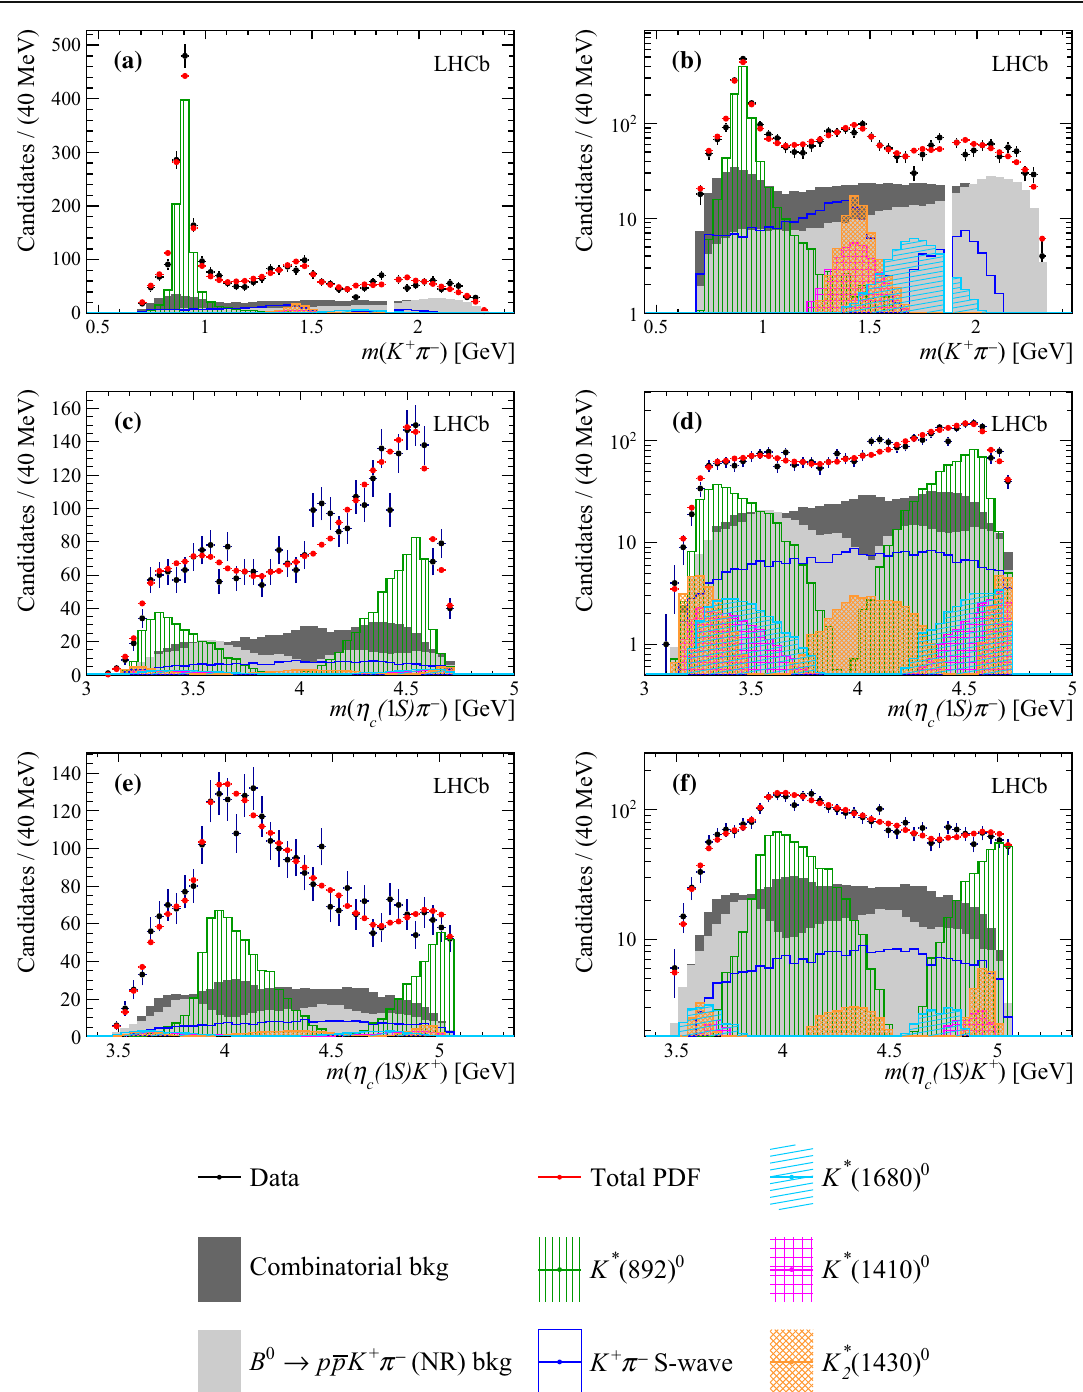
Fig. 8 Projections of the data and amplitude fit using the baseline model onto a m ( K + π − ) , c m (η c π − ) and e m (η c K + ) , with the same projections shown in b , d and f with a logarithmic vertical-axis scale.